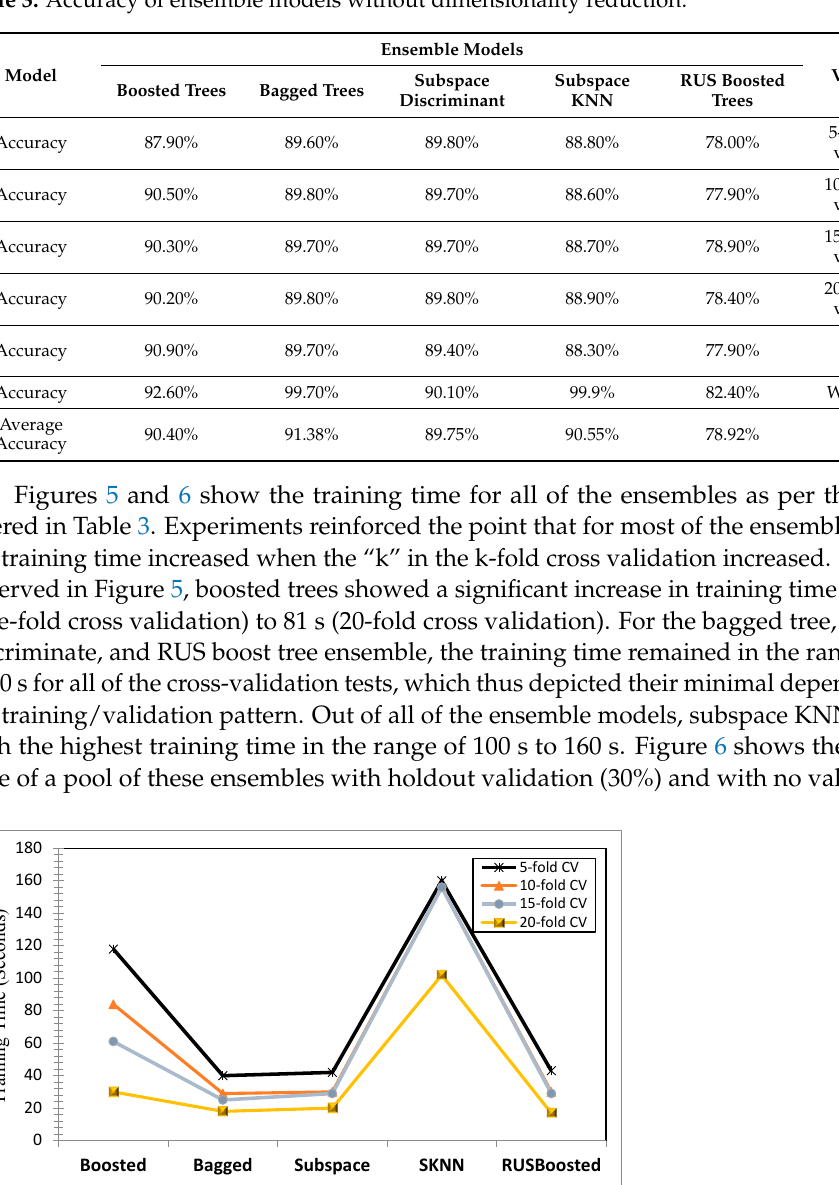
Table 3. Accuracy of ensemble models without dimensionality reduction.